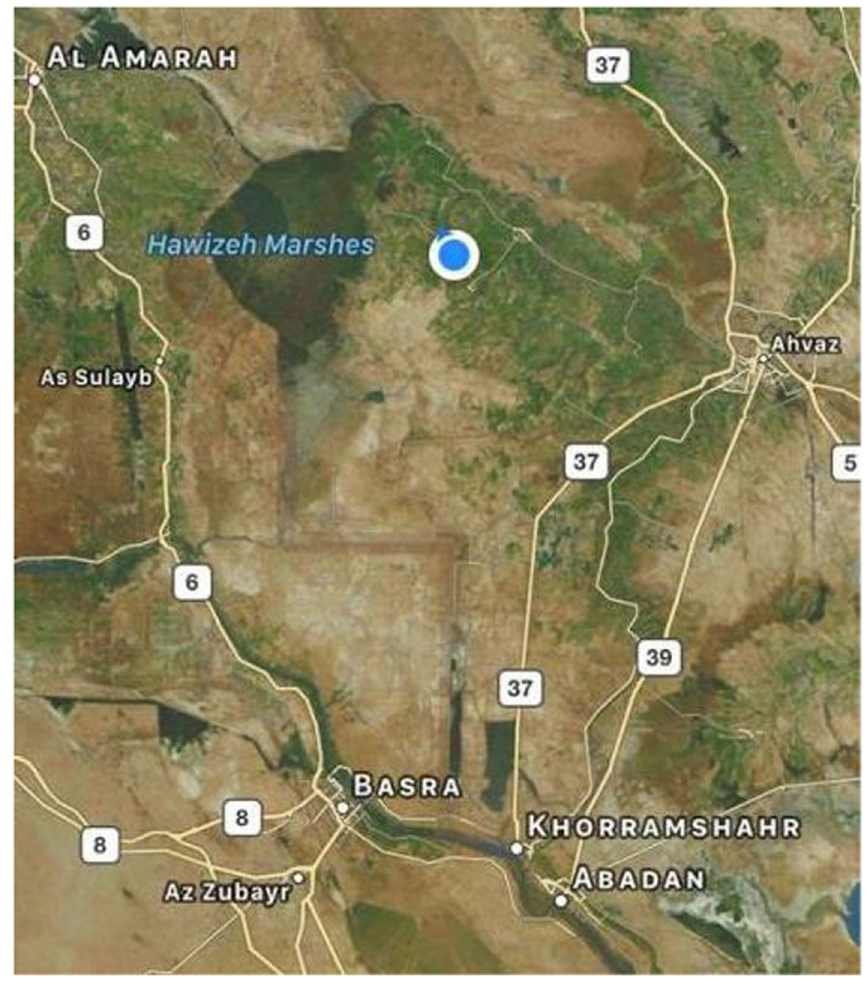
Fig. 6 Universal situation of